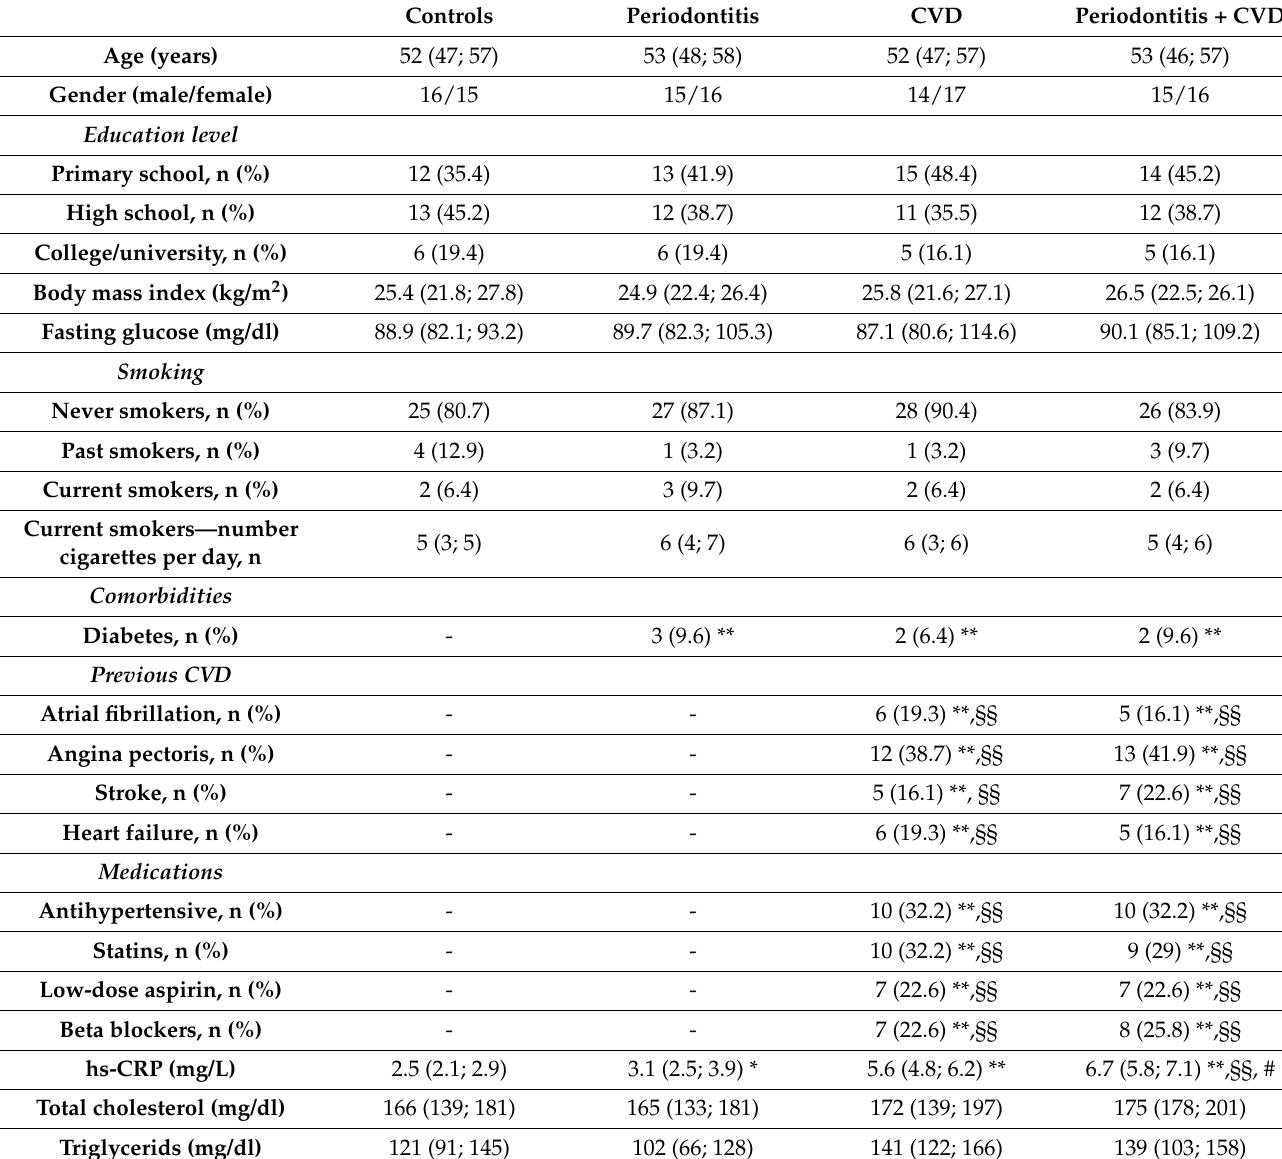
Table 1. Demographic characteristics of the patients. Data are shown as a median (25th; 75th percentiles) or a number with a percentage. CVD, cardiovascular disease. * p < 0.001 and ** p < 0.001 differences vs. controls. # p < 0.008 differences